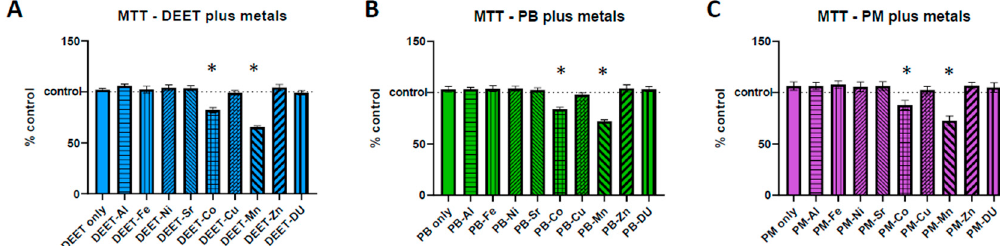
Figure 1. Toxicity of organic and metal combination exposures on brain microvascular endothelial cells (BMEC). Toxicity assessment via MTT assay on BMEC cultures for combinations of an each organic compound with individual metals. ( A ) DEET (10 µM) plus metals (1 µM), ( B ) pyridostigmine bromide (PB) (10 µM) plus metals (1 µM), and ( C ) permethrin (PM) (10 µM) plus metals (1 µM). Dotted line at 100 indicates 100% of control measurement: values below the line indicate that the dose is toxic to the cells and viability is decreased. Data represent the mean and standard deviation of three independent experiments. An * denotes a statistically significant difference from control at p < 0.05.